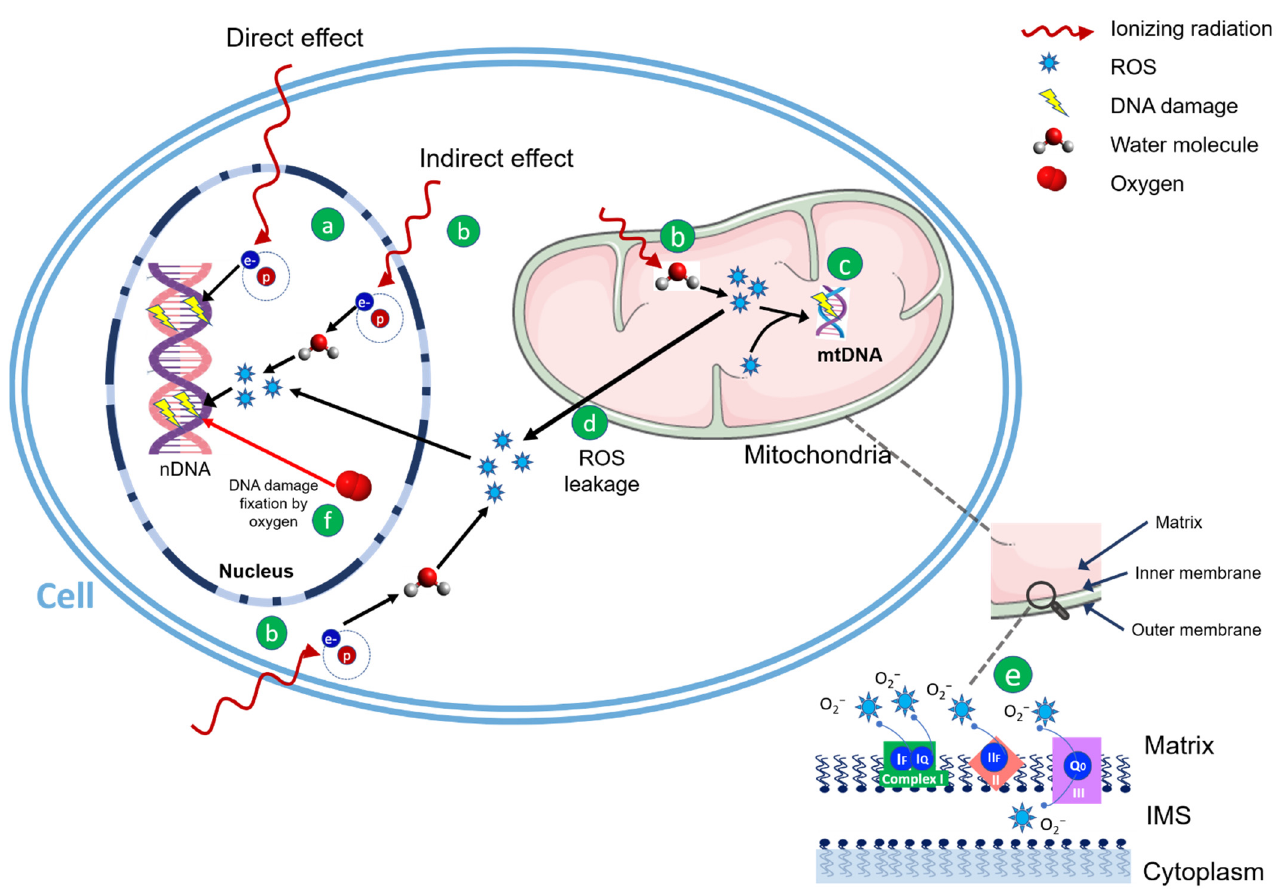
Figure 1. DNA damage by IR can be direct or ROS-mediated. In the direct effect (a), DNA molecules are hit directly by the secondary electrons produced by the incident radiation, resulting in cleavage of the chemical bonds and lesions such as single- and double-strand breaks. In the indirect effect (b), secondary electrons interact with water to produce ROS which attack DNA molecules in the cell, in the nucleus and in the mitochondria. When mitochondria are exposed to IR, the generation of ROS rises and can harm mtDNA in the matrix (c) and nDNA by leakage in the cell (d). Some of the recognized locations for ROS formation during oxidative phosphorylation in ETC are shown in the bottom right (e) and include complexes I and III, which are the primary sources of ROS in mitochondria, as well as complex II. The most prevalent ROS in mitochondria are superoxide anions, extremely reactive free radicals that are easily changed into other ROS such as hydrogen peroxide (H 2 O 2 ) and hydroxyl ions (OH). The indirect ROS-mediated effect of IR is enhanced in the presence of oxygen: under aerobic conditions, oxygen reacts extremely rapidly with DNA radicals, fixating the damage and ensuring an unrepairable strand break (f); in the absence of oxygen, DNA radicals can be reduced, and DNA repairs to its original form, preventing strand damage. Abbreviations: ETC, electron transport chain; IMS, intermembrane space; IR, ionizing radiation; mtDNA, mitochondrial DNA; nDNA, nuclear DNA; ROS, reactive oxygen species.